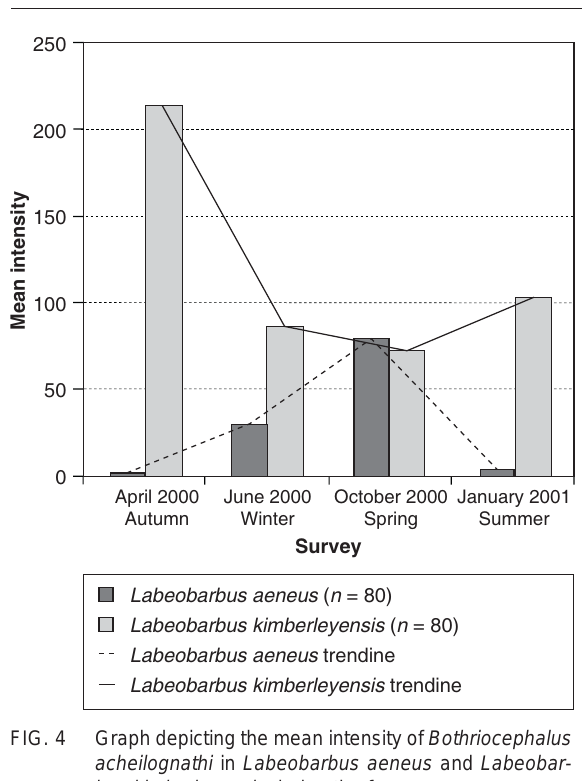
Graph depicting the mean intensity of Bothriocephalus acheilognathi in Labeobarbus aeneus and Labeobar- bus kimberleyensis during the four